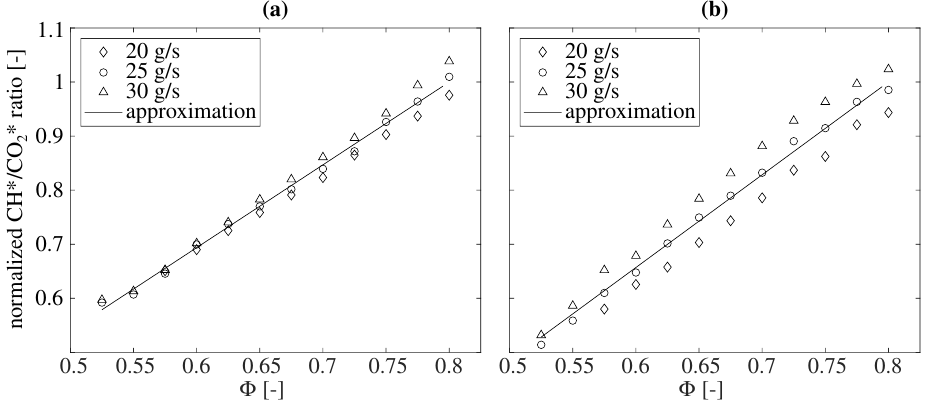
Figure 5. The dependence of the CH*/CO 2 * chemiluminescence ratio on the equivalence ratio Φ for the combustion of natural gas in ( a ) and kerosene in ( b ) under atmospheric conditions for different air mass flow rates. All values are normalized to the approximation at Φ